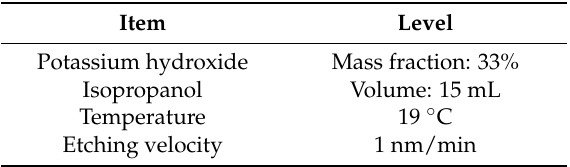
Table 2. Parameters of static alkaline etching (SAE).